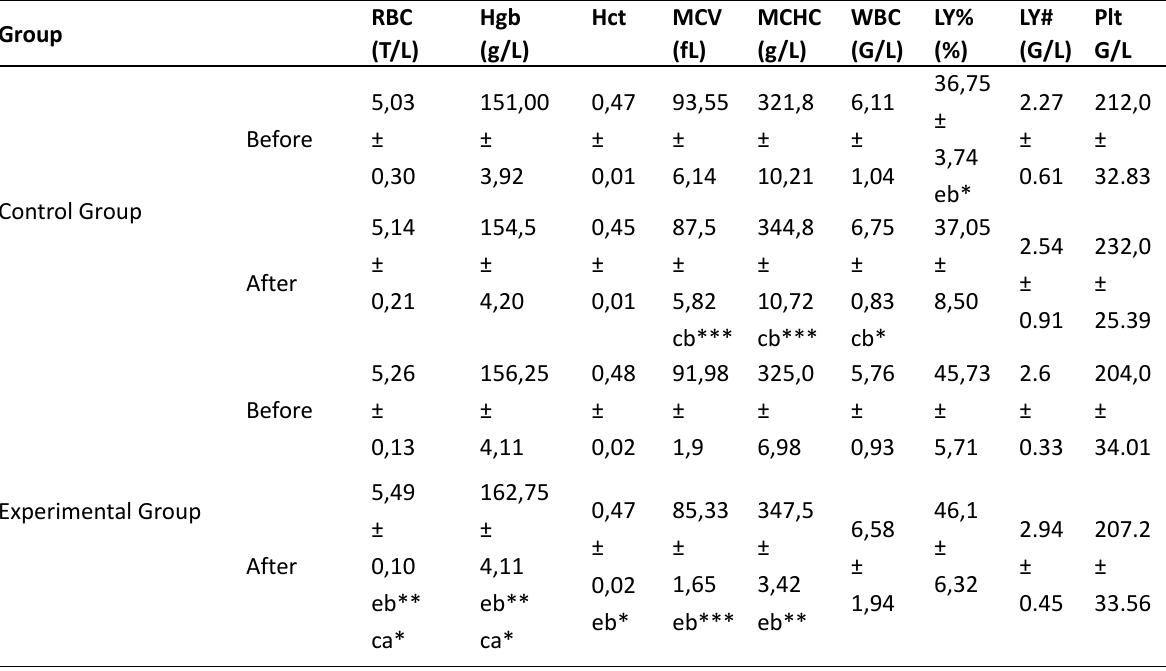
Table 4. Results of the hematological analyses of the rowers from the control and experimental group at the beginning and the end of the test